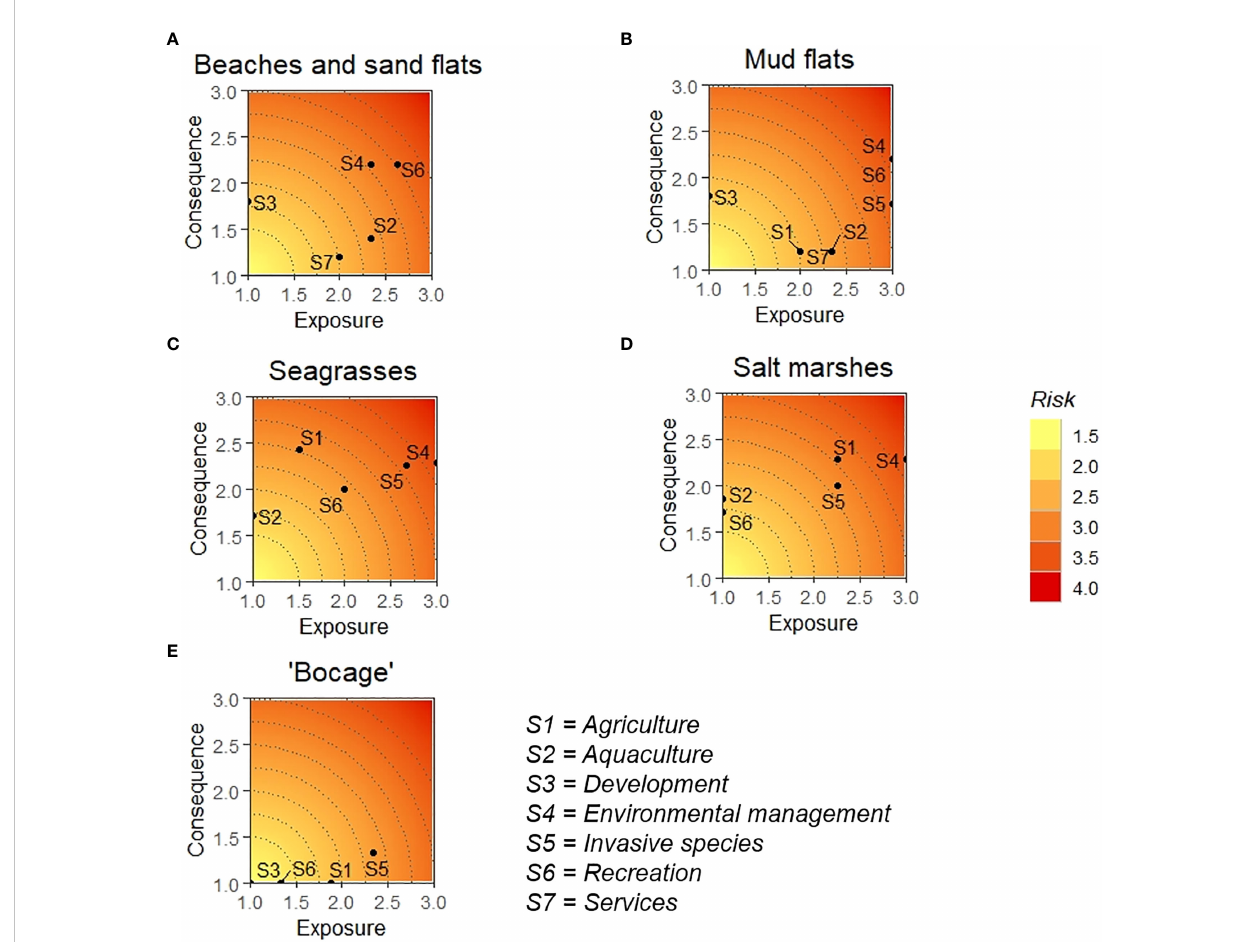
FIGURE 5 Risk plots showing maximum consequence and exposure scores by habitats ( A beaches and sand fl ats, B mud fl ats, C seagrasses, D salt marshes, E 'Bocage') with coordinates representing pressures (S1: agriculture, S2: aquaculture, S3: development, S4: environmental management, S5: invasive species, S6: recreation, S7: